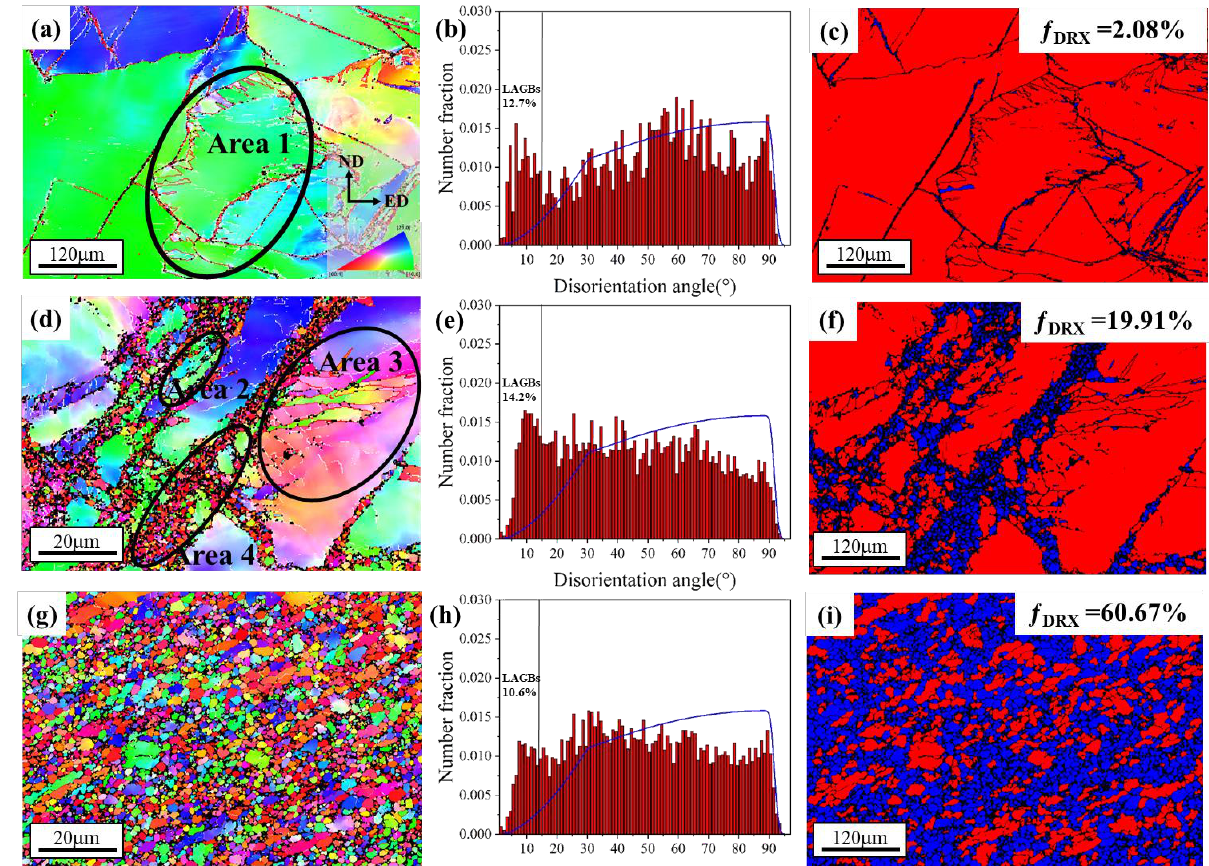
Figure 5. EBSD IPF maps with ED projected for ( a ) 1P, ( d ) 4P and ( g ) 12P samples; ( b , e , h ) show the disorientation angle distribution. Recrystallized area fractions of deformed samples are shown in ( c , f , i ), where the DRX grains are in blue and the deformed grains are in red. The low-angle grain boundaries (LAGB; 2° ≤ θ ≤ 15°) and high-angle grain boundaries (HAGB, θ > 15°) are defined, which were highlighted by thick white and red lines, respectively. As shown in Figure 5a, coarse grains induced by homogenized treatment were not refined and a large number of dynamic recrystallized (DRX) fine grains formed along the GBs and inner of coarse grains. Some sub-grain boundaries (sub-GB) with a disorientation angle exceeding 2° can be clearly seen in the coarse grains which will promote the DRX process by absorbing the dislocation during the deformation [9,49]. Due to the presence of a high density of dislocations, internal grain disorientation appears to result in the variation in color of the IPF maps. The same phenomenon is also shown in 4P (Figure 5d) and 12P (Figure 5g) samples in the deformed grains. After 4 passes, the sample shows a typical bimodal microstructure [9,50,51], where coarse deformed grains are surrounded by massive fine DRX grains. The area fraction of recrystallization grains reached 19.91% as shown in Figure 5f, which is increased by 17.83% compared to the